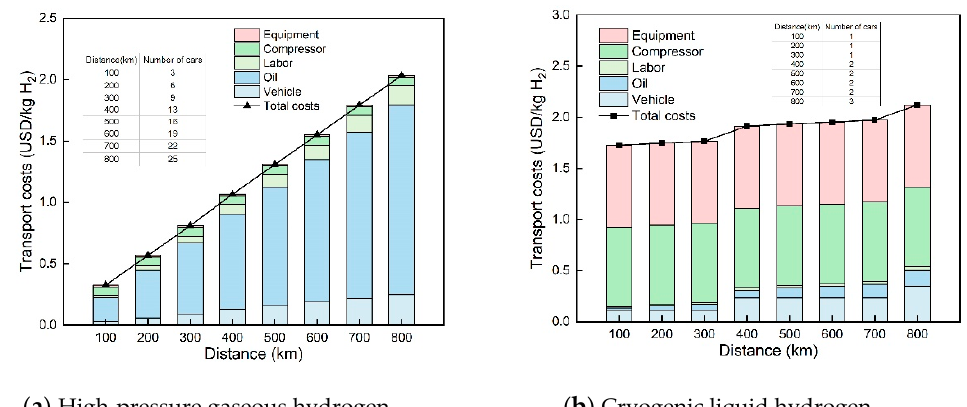
Figure 7. Hydrogen demand (10 t/day) transportation cost.